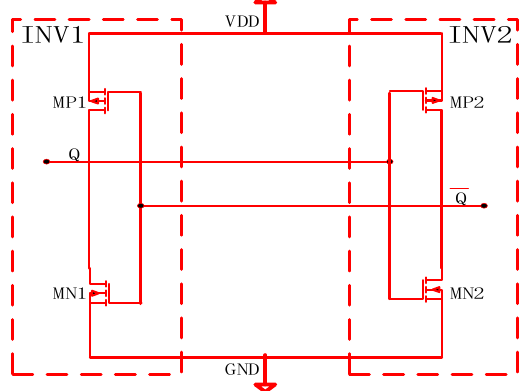
Figure 4. The main circuit structure of a SRAM cell.